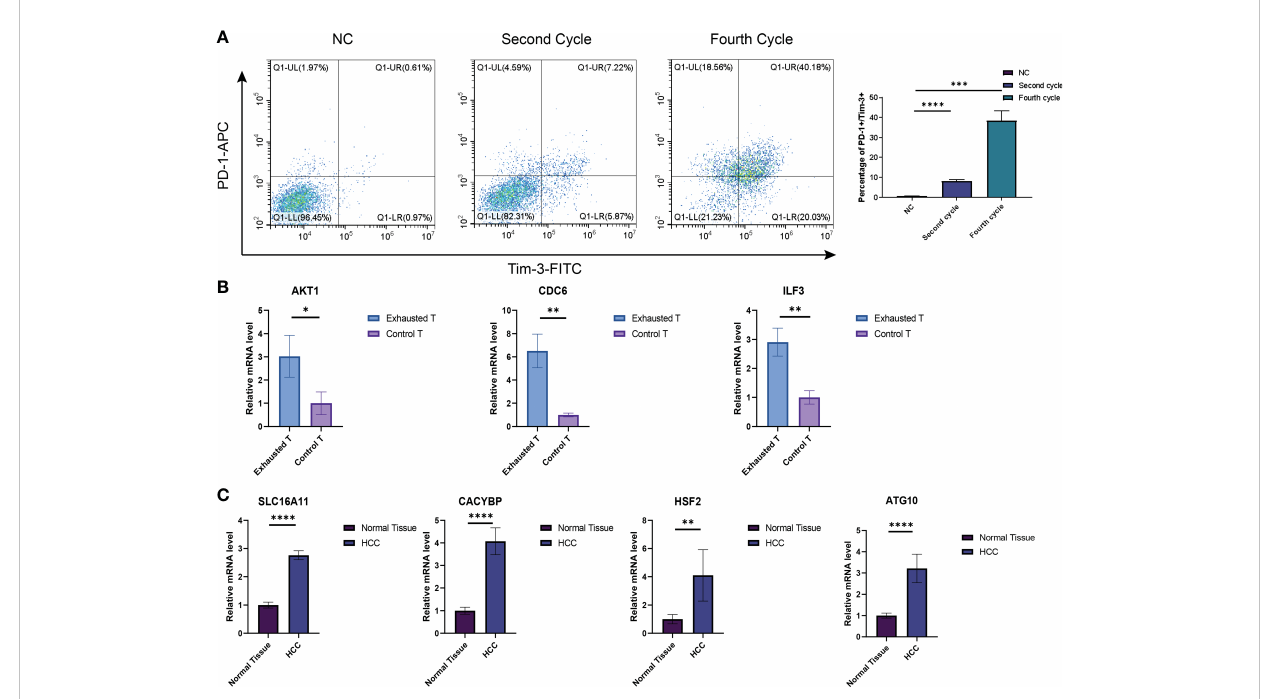
FIGURE 11 Veri fi cation of Tex signature by in vitro experiments. (A) Detection of the inhibitory receptor PD-1 and Tim-3 in T cells with different cycles of expansion. N=3 (B) qRT-PCR was used to detect exhaustion gene expression between the fourth cycle expanded T cells and NC cells. N = 3 (C) The expression of SLC16A11, CACYBP, HSF2, and ATG10 in HCC tissues and control tissues was detected by PCR. N = 5. *indicates signi fi cant difference at p < 0.05, ** indicates signi fi cant difference at p < 0.01, *** indicates signi fi cant difference at p < 0.001, **** indicates signi fi cant difference at P <0.0001.